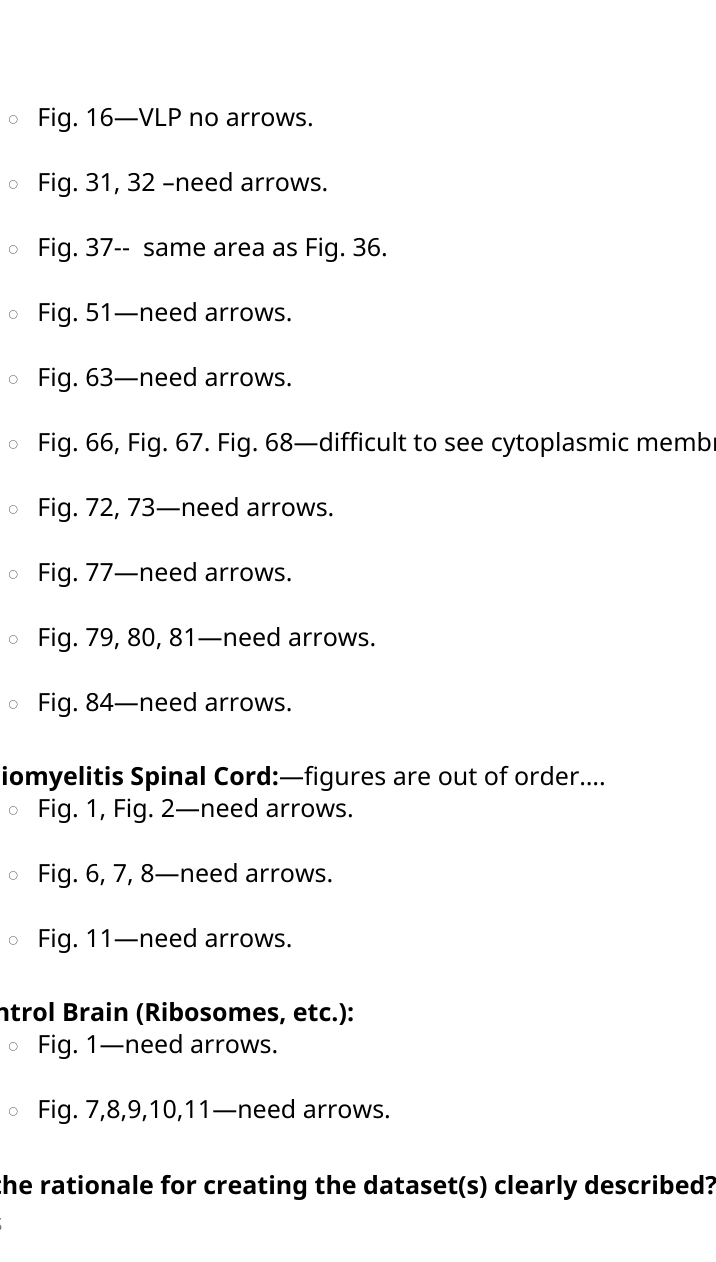
Fig. 16—VLP no arrows. ○